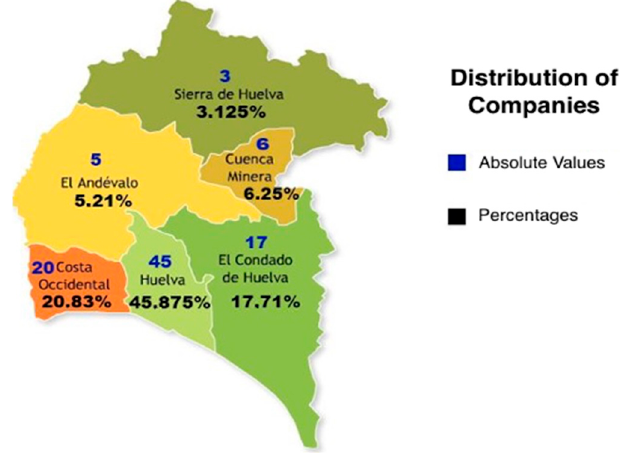
Figure 1. Geographic distribution of the companies.